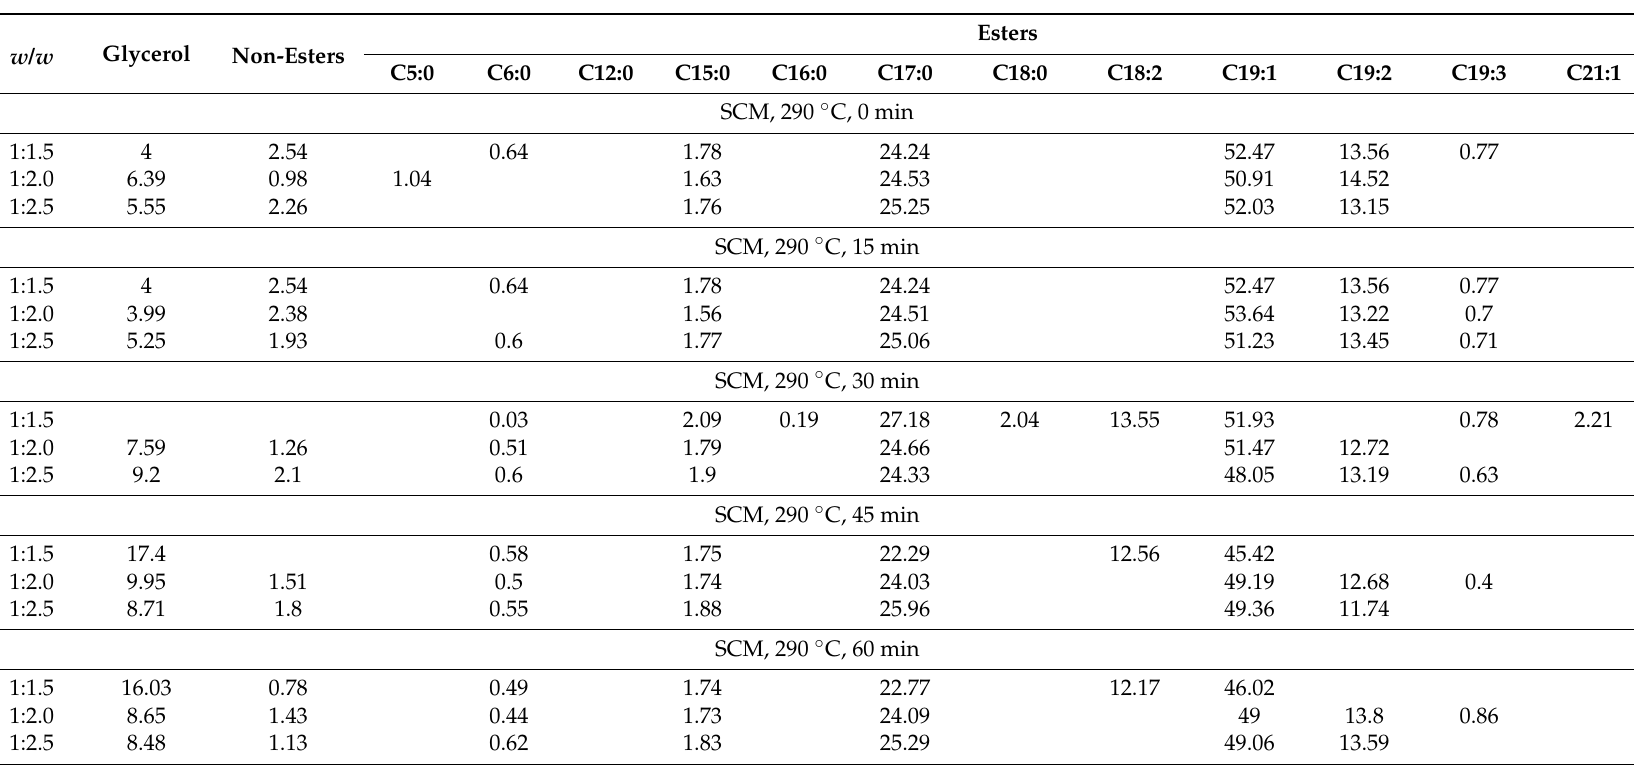
Table 4. The weight percentage of compounds according to the carbon number of liquid products obtained at different holding times for different waste pig fat to methanol ratios at transesterification temperature of 290 ◦